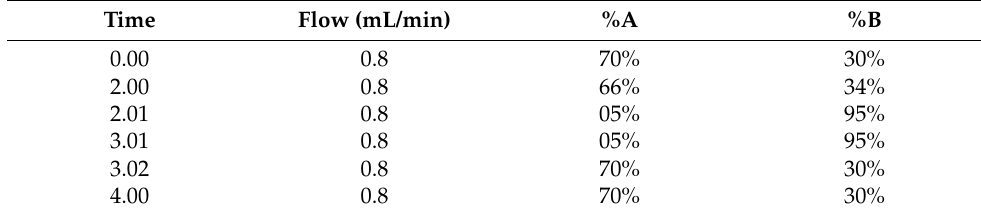
Table 2. Gradient table of the UPLC evaluation program. Time Flow (mL/min) %A